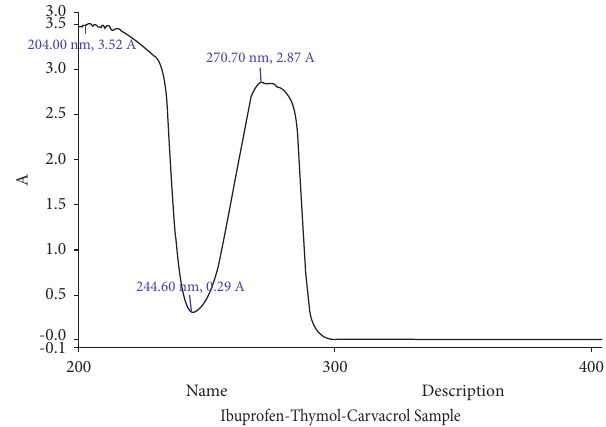
Figure 1: Absorbance area for thymol and carvacrol. Thymol and carvacrol standards were measured over the range of 200nm to